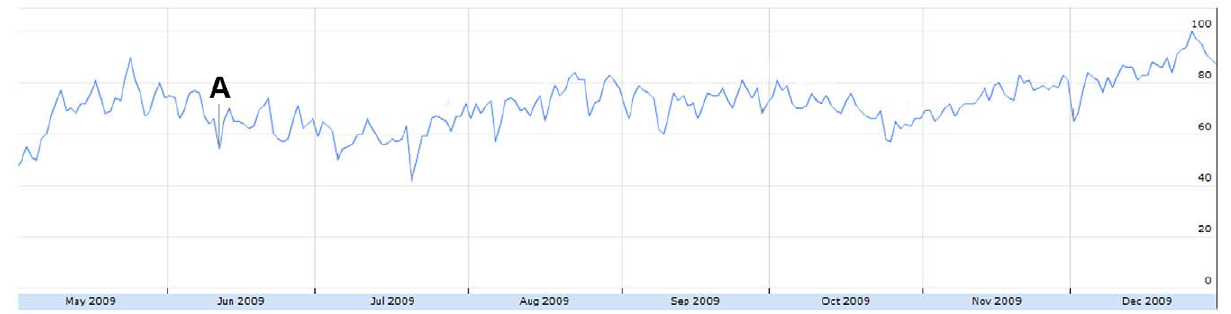
Figure 15. The relative proportion of tweets sharing resources from May 1 to December 31, 2009. Figure was scaled to the highest peak on Dec. 25 where 77.27% of all tweets shared resources. The peak was assigned a score of 100. A=June 11: WHO pandemic level 6